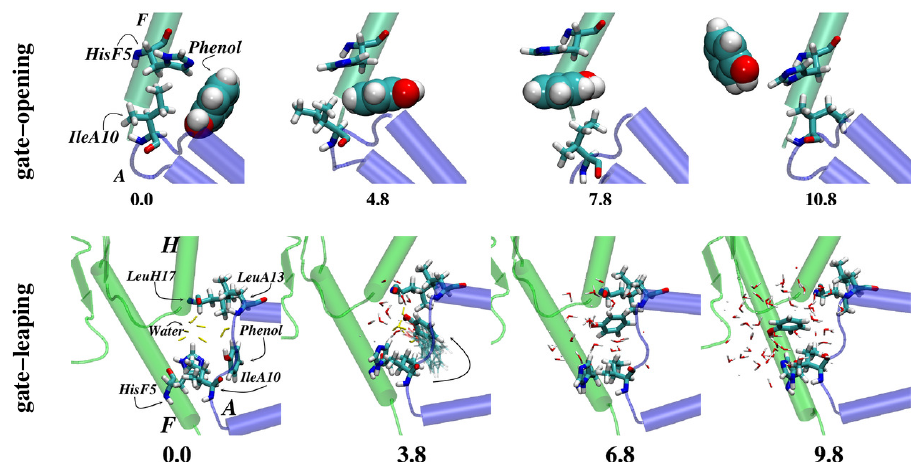
Figure 7. Gate-opening vs. gate-leaping mechanisms. Top-view and side-view snapshots for two different phenol dissociation mechanisms, gate-opening and